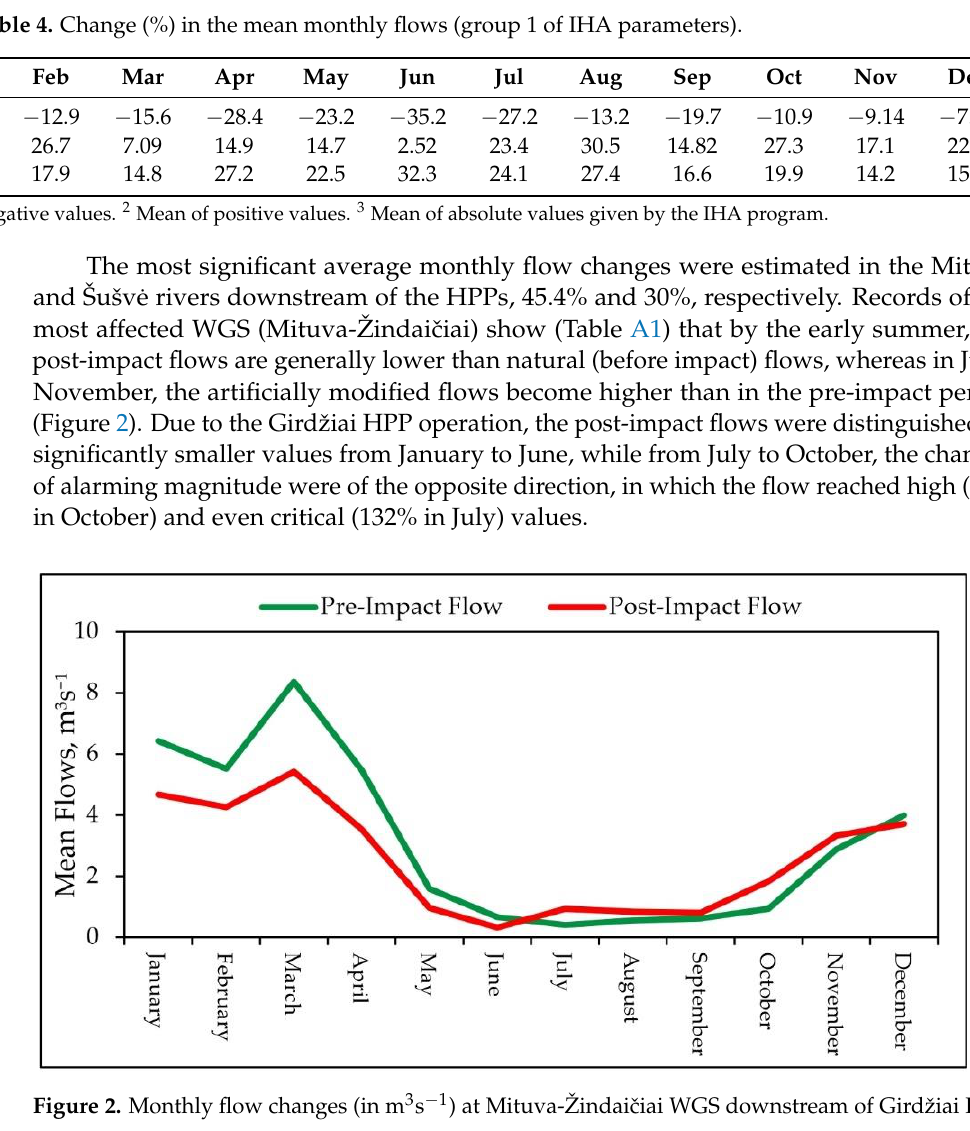
Table 5. Change (%) in the magnitude and duration of annual extreme flows (group 2 of IHA parameters). Parameters